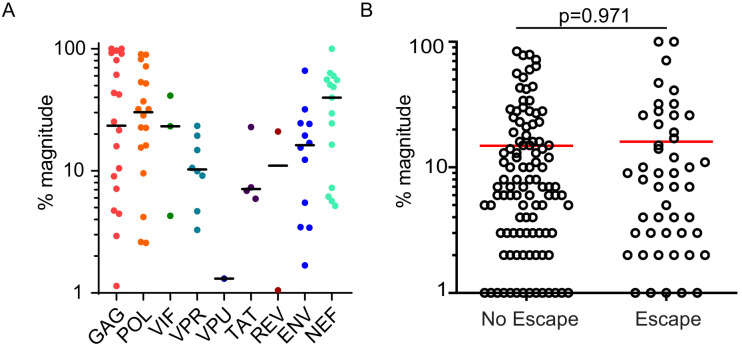
HIV-1-specific T cell responses in PLWH on ART.(A) The % magnitude of each mapped T cell response (n = 25 participants, n = 166 epitopes) was calculated as a percentage of the total response measured by ELISpot in that individual, and graphed by HIV-1 protein. Horizontal bars represent median values and each point represents an individual T cell response. (B) The percent magnitude was calculated for all reactive T cell responses for which there was sequencing data from outgrowth viruses (n = 23 participants, n = 151). There was no difference in the % magnitude between T cell responses that targeted epitopes harboring escape variants (n = 49, median % magnitude = 7.5) and epitopes with no escape variants (n = 102, median % magnitude = 7.0). (Mann Whitney two-tailed test, p=0.971).